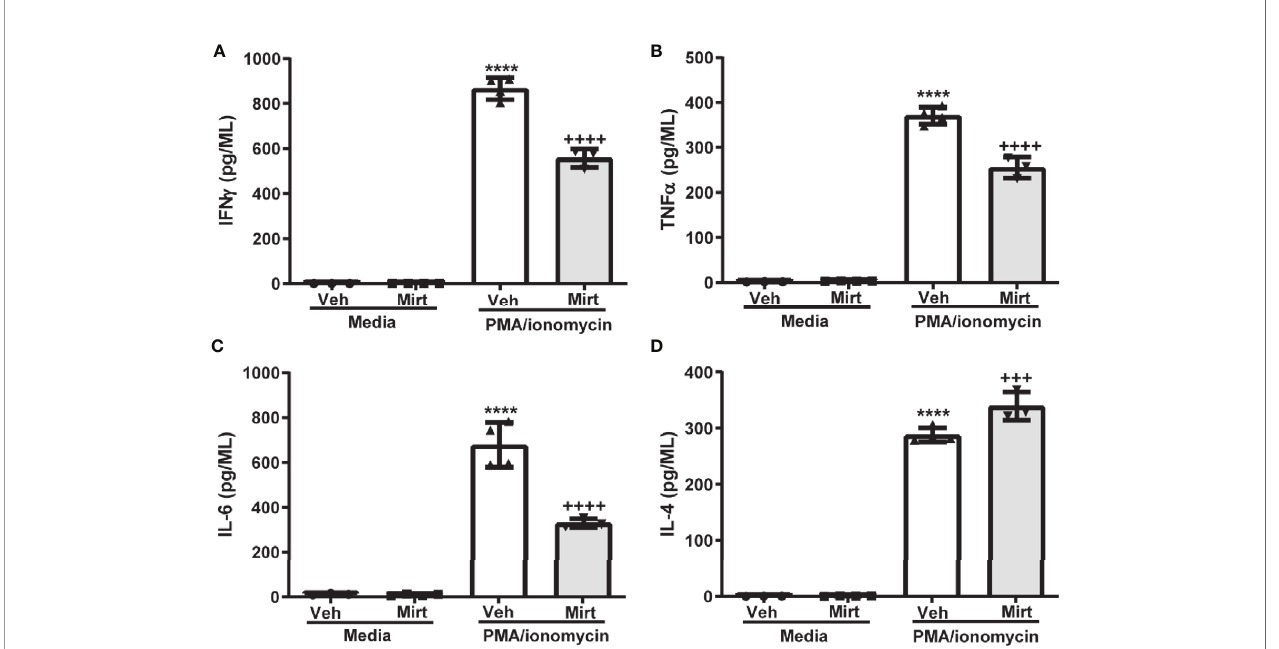
FIGURE 5 | Mirtazapine alters the cytokine secreting pro fi le of the hepatic B cell population. Puri fi ed hepatic B cells were isolated from vehicle or mirtazapine treated mice and stimulated in vitro ) with PMA/ionomycin and cytokine release measured. Production of proin fl ammatory cytokines IFN- g (A) , TNF a (B) , and IL-6 (C) were lower from the hepatic B cell population isolated from mirtazapine vs vehicle treated mice, whereas production of the anti-in fl ammatory cytokine IL-4 (D) was increased in the B cell population isolated from mirtazapine vs vehicle treated mice. (A) ****p ≤ 0.0001 vehicle + PMA/ionomycin vs. all other groups; ++++ p ≤ 0.0001 mirtazapine +PMA/ionomycin vs. all other groups, (B) ****p ≤ 0.0001 vehicle + PMA/ionomycin vs. all other groups; ++++ p ≤ 0.0001 mirtazapine + PMA/ionomycin vs. all other groups, (C) ****p ≤ 0.0001 vehicle + PMA/ionomycin vs. all other groups; ++++ p ≤ 0.0001 mirtazapine + PMA/ionomycin vs. all other groups, and (D) ****p ≤ 0.0001 vehicle + PMA/ionomycin and mirtazapine + PMA/ionomycin groups vs. all other groups; and +++ p ≤ 0.001 vehicle + PMA/ionomycin vs. mirtazapine + PMA/ionomycin group (n = 3 and 4 mice per